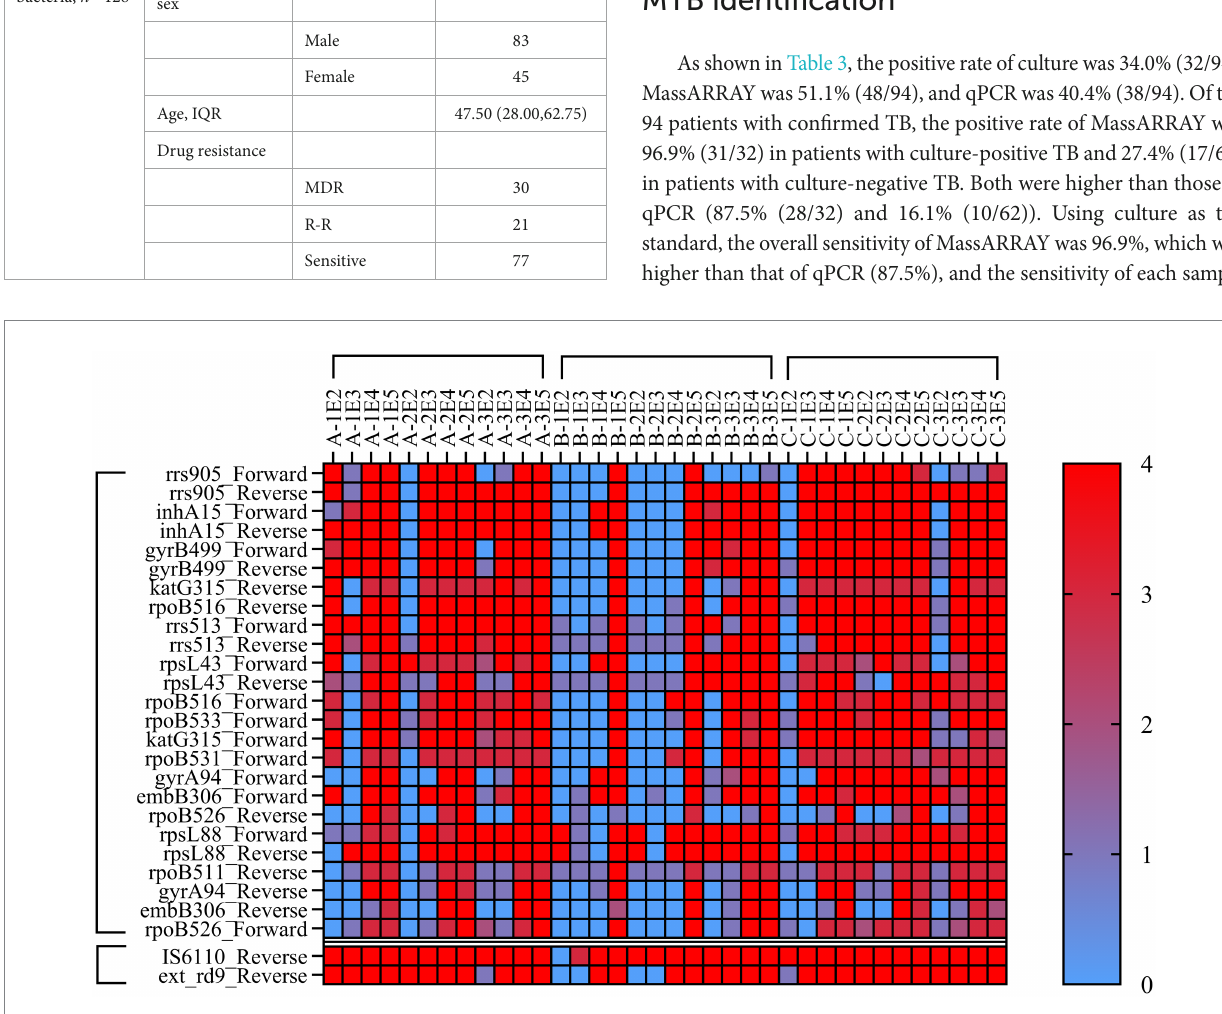
FIGURE 2 Heat Map of minimum detection limit for MassArray. Note: A = Magnetic bead method, B=Column extraction method, C = Glass bead method ， 1, 2, 3 refer to H37Rv, CMCC95102, CMCC95103. E2-E5 refer to 10 2 –10 5 CFU/mL. Each sample was tested by MassArray for three times, and the lowest detection value was selected for statistical analysis. 0–4 refer to the quality of the test results, 0 = No-Alleles, 1 = Low Probability, 2 = Aggressive, 3 = Moderate, 4 = Conservative. The value of 1 was used to determine the lowest bacterial load to trigger positive